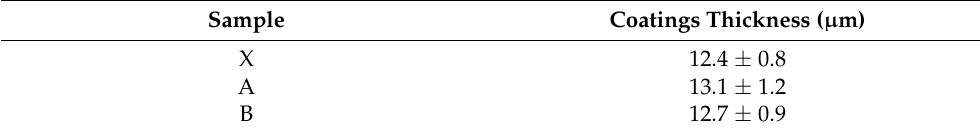
Table 2. Coatings thickness measured with the thickness gauge.